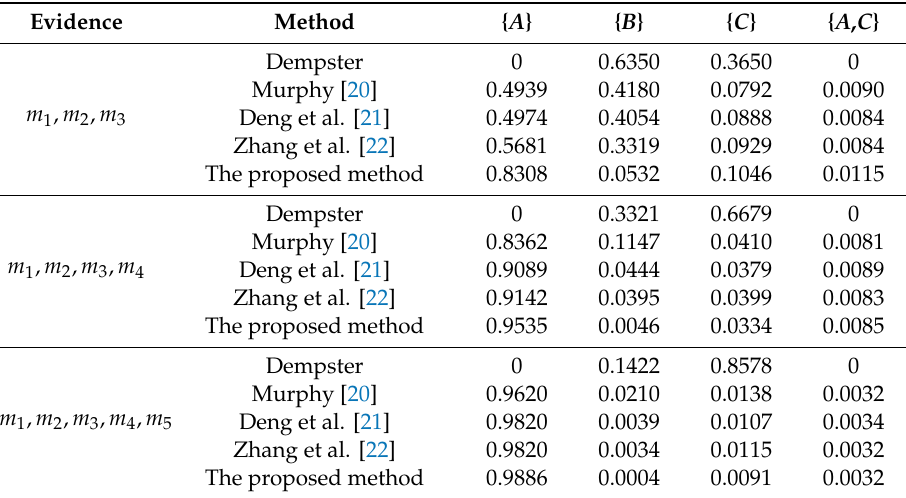
Table 2. Results of the evidence using di ff erent fusion